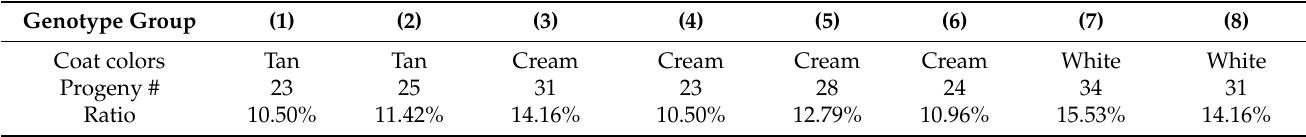
Table 1. Analysis of the relationship between genotypes and coat colors among the progeny generated by